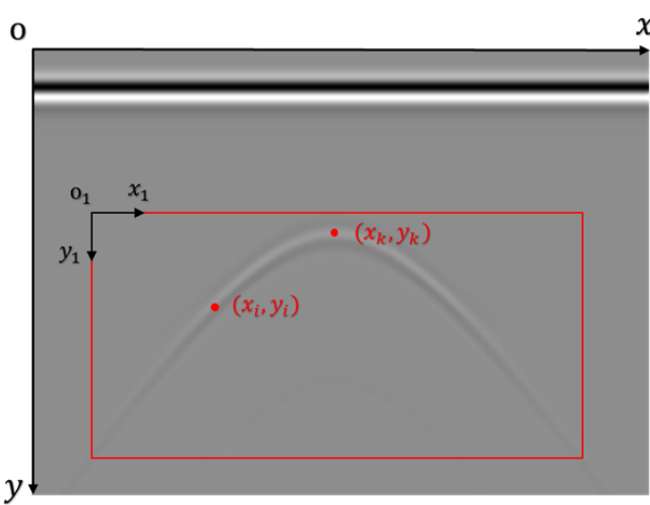
Figure 8. Coordinate transformation of key